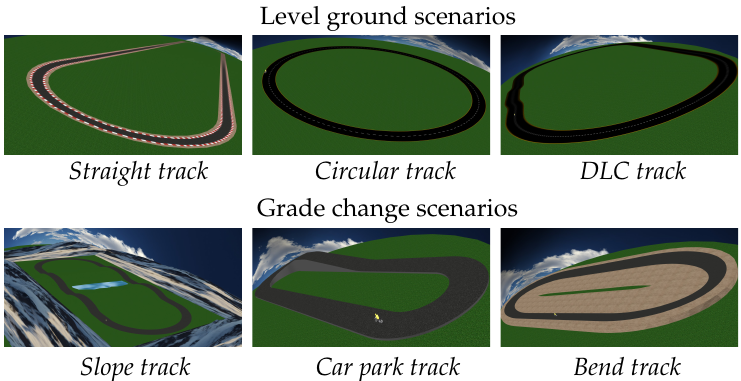
Figure 6. Scenarios created to test the estimator behavior.